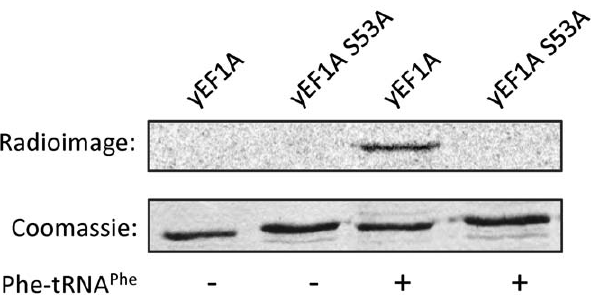
Figure 6. Ser-53 in eEF1A is the unique glucosylation site in the presence of Phe-tRNA Phe . Wild type yeast eEF1A (yEF1A) and the yeast eEF1A S53A mutant (yEF1A S53A; each 1 m M) were subjected to an in vitro glucosylation reaction with Lgt3 (140 nM) in the presence or absence of Phe-tRNA Phe .